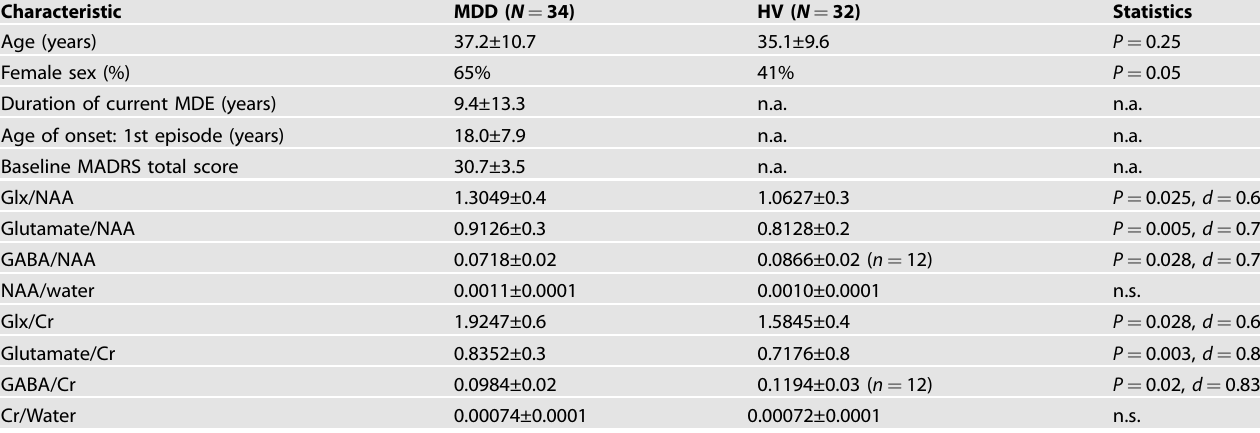
Table 1. Characteristics of participating